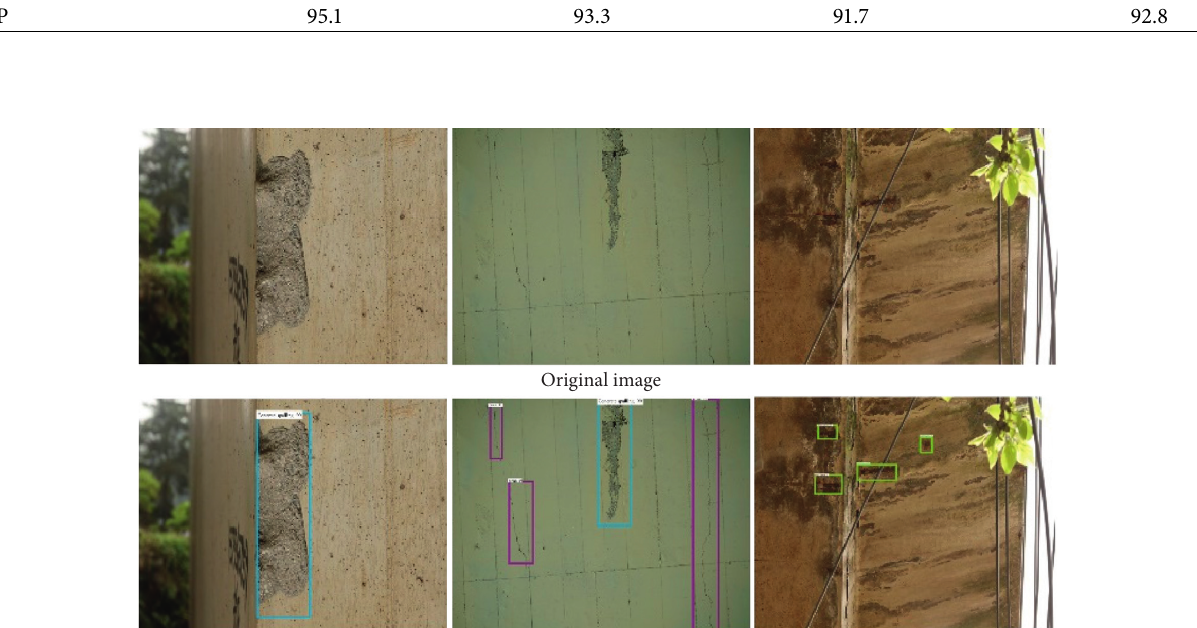
Figure 16: Bridge defects recognition by R-FCN network.